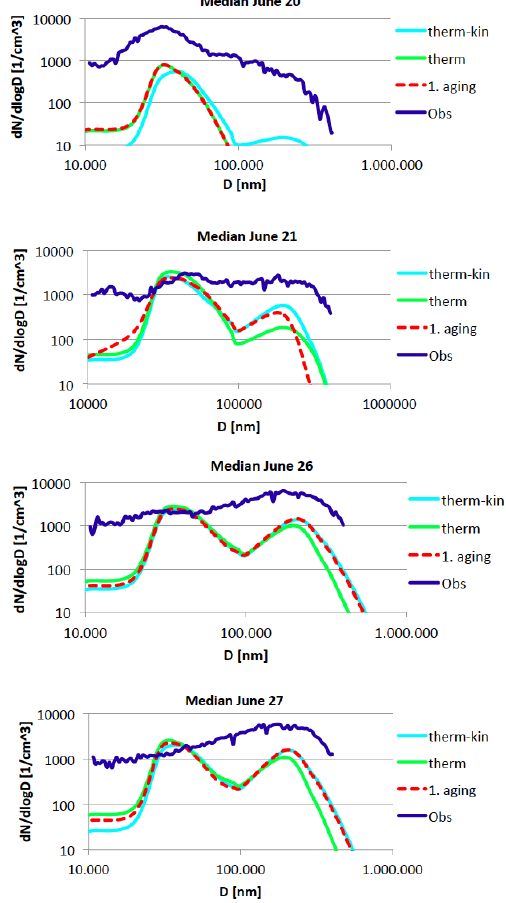
Fig. 7. Median dry aerosol number size distribution [cm − 3 ] at Puy- de-Dôme for fresh air masses (20 and 21 June) and aged air masses (26 and 27 June). Blue line: measured median; light blue line: mod- elled daytime median with the thermodynamic-kinetic approach and 10% aging; green line: modelled daytime median with the pure thermodynamic approach; red line: modelled daytime median with the first aging step only in the thermodynamic-kinetic approach and 10%